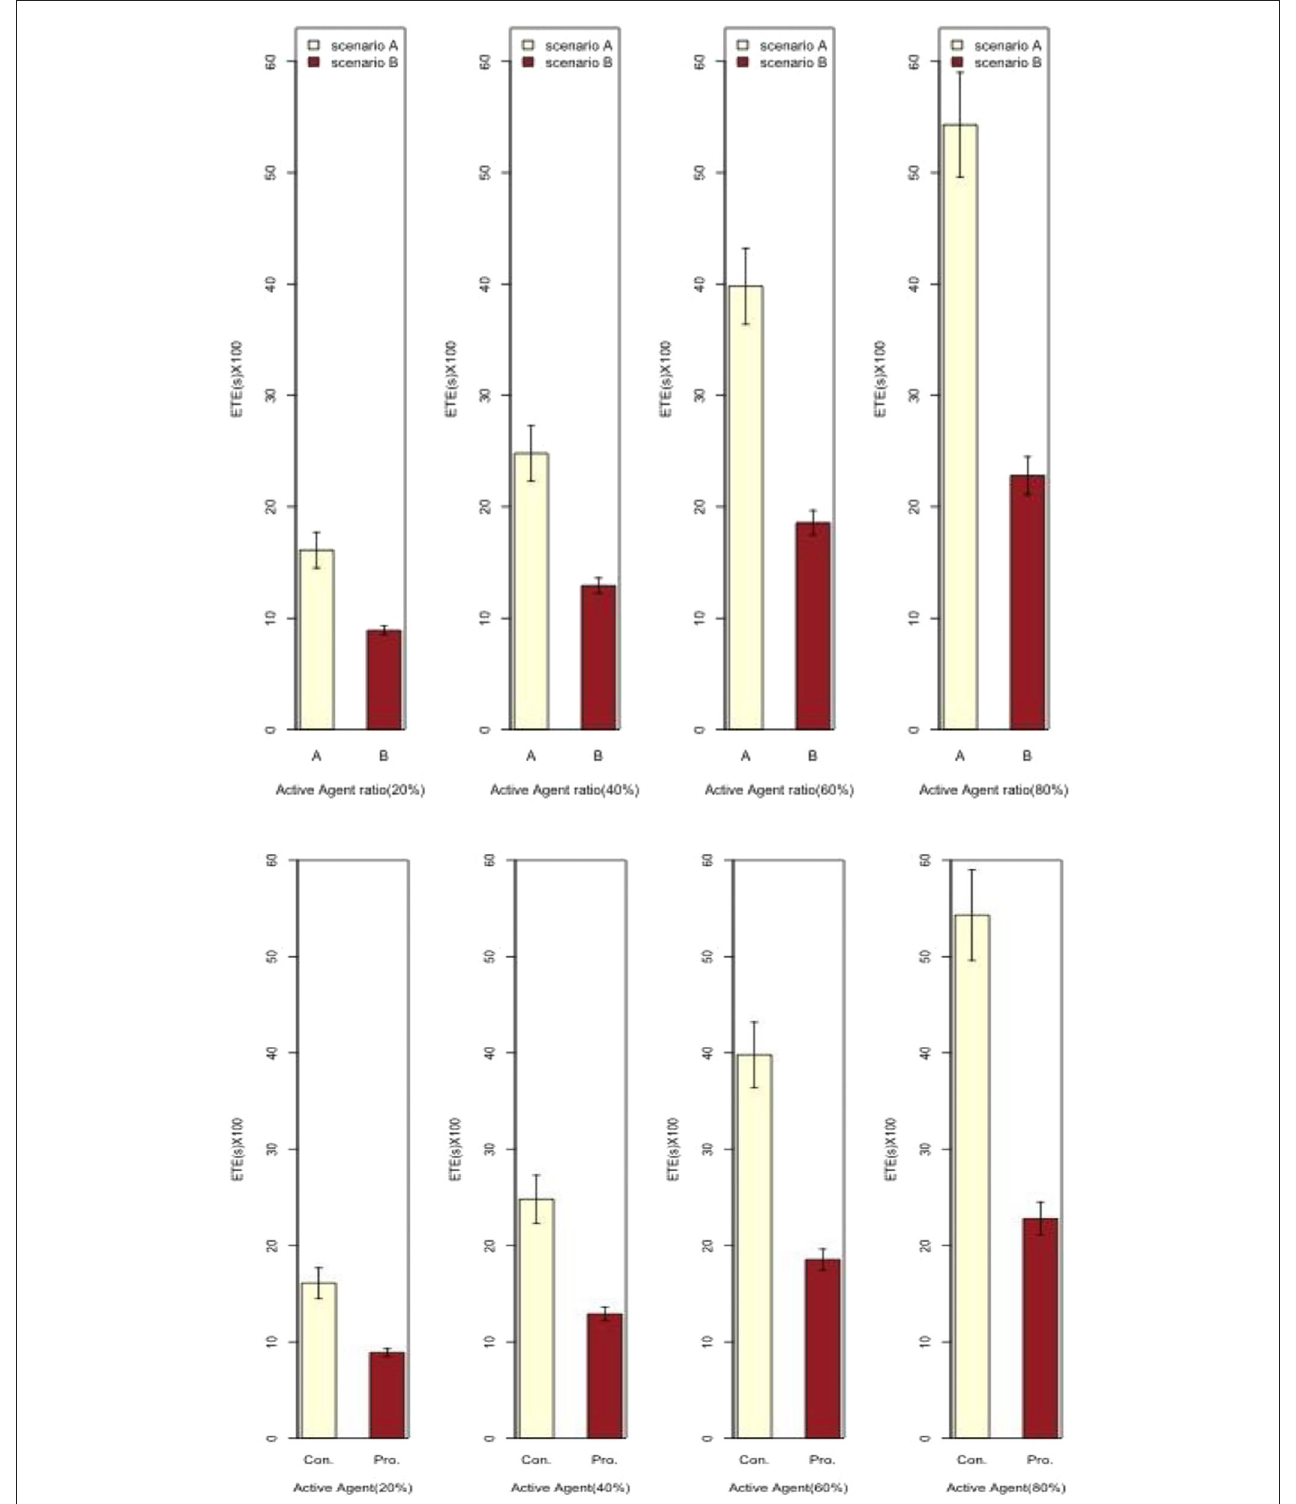
FIGURE 6 | ETE for conventional (Scenario A) and proposed (Scenario B) hours (source: the authors).